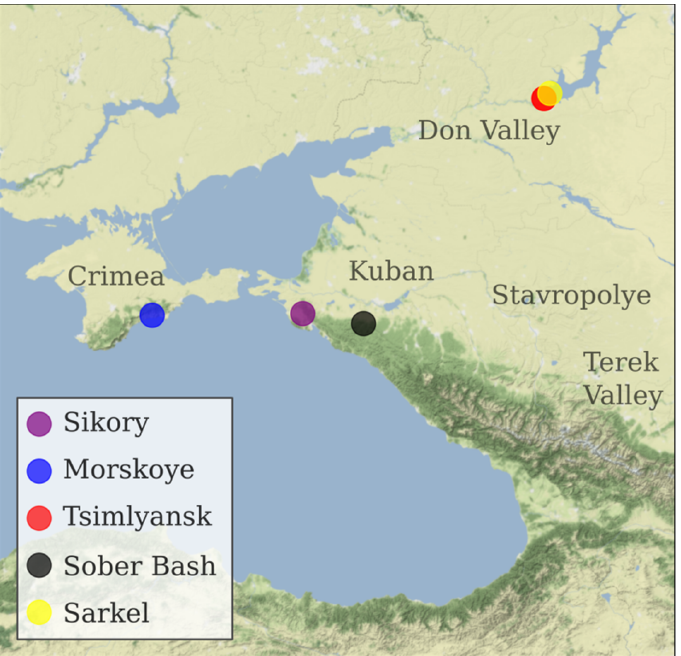
Figure 4. Geographical location of vineyards in southern Russia where the 10 grapevine samples included in the study were recovered. Table 5. Genotyped V. vinifera specimens.